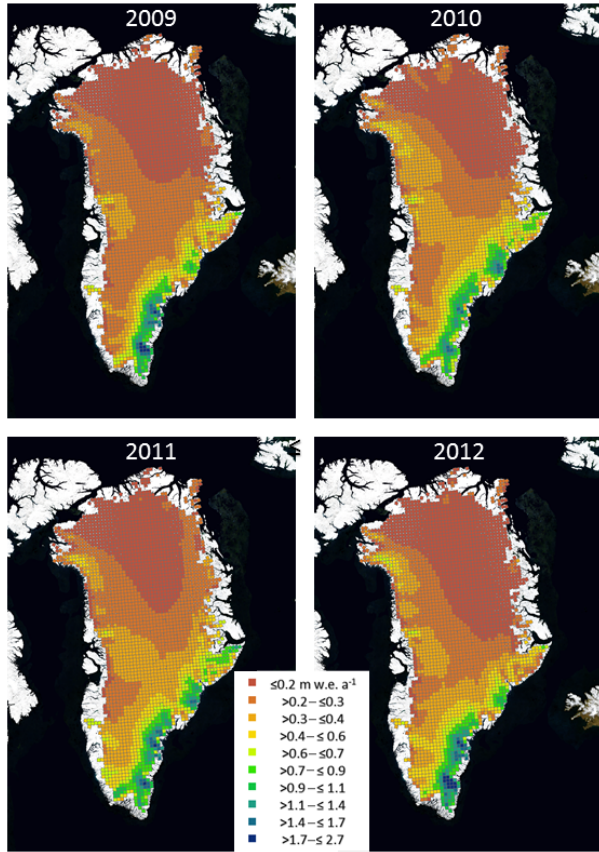
Figure 4. Radar-derived annual accumulation rate (mw.e.a − 1 ) for 2009 through 2012 from Operation IceBridge snow radar data, rep- resenting the top layer in each year (1 July to 30 April).